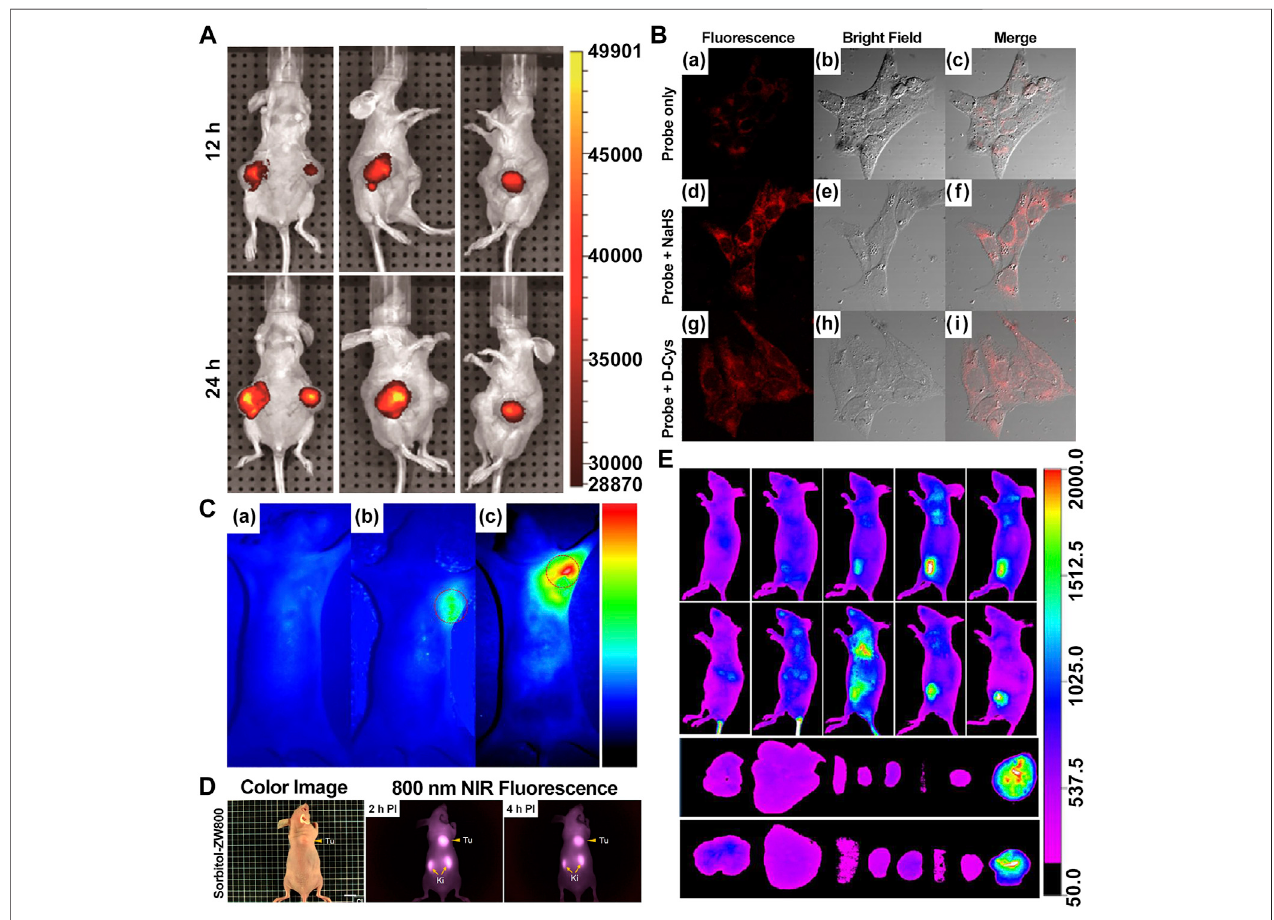
FIGURE 2 | Presentation of imaging based on Cy7s. (A) . In vivo near-infrared fl uorescence imaging of MCF-7 tumor-bearing mouse xenografts injected with the genistein-IR783 conjugate at 12 and 48 h, respectively. Reproduced with permission from (Guan et al., 2019). (B) . Fluorescence imaging of exogenous (d – f) and endogenous (g – i) H 2 S in living MCF-7 cells incubated with NIR-H 2 S for 30 min (10 μ M). Reproduced with permission from (Xiong et al., 2018). (C) . In vivo NIR fl uorescence images of